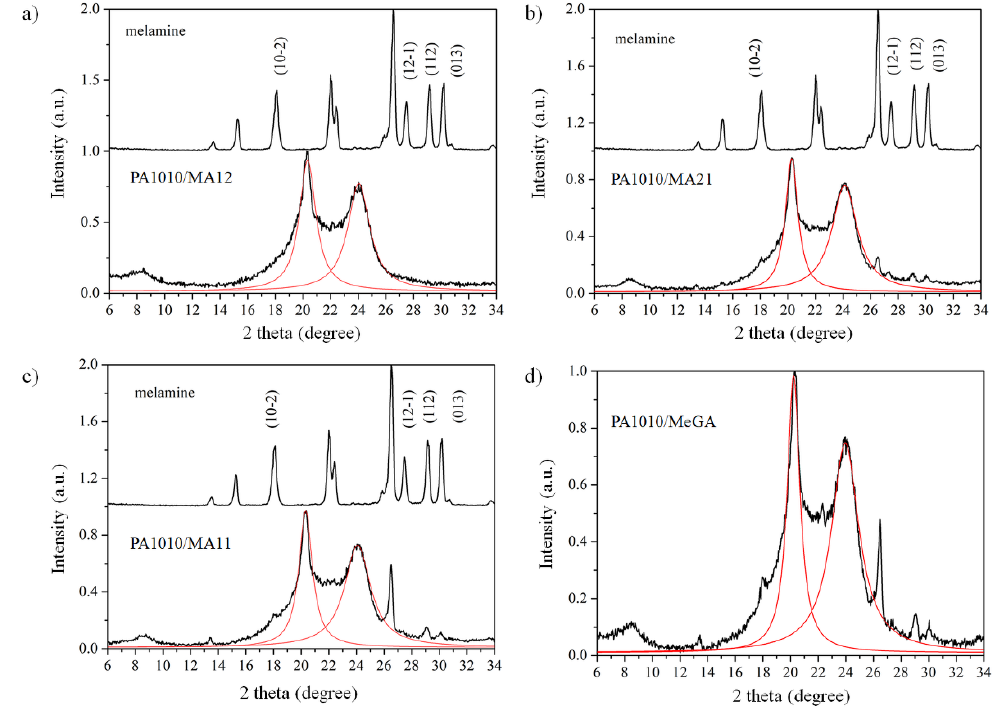
Figure 9. XRD pattern of PA1010 with MA complexes. ( a ) polyamide with MA12; ( b ) polyamide with MA21; ( c ) polyamide with MA11; ( d ) polyamide with MeGA. The red solid lines represent the Lorenz fitting of α and γ diffraction planes.